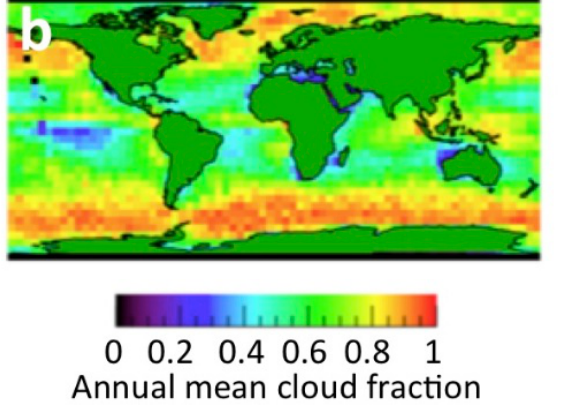
tion of low clouds. Both panels are based on the 1km-resolution MODIS cloud mask and the MODIS cloud top pressure product (with low cloud top pressure exceeding 700hPa). Panel (a) uses a 2-D search to determine the distance to clouds. Panel (b) considers as cloud (clear) the MODIS cloud mask values “probably cloud” and “confident cloud” (“probably clear and confident